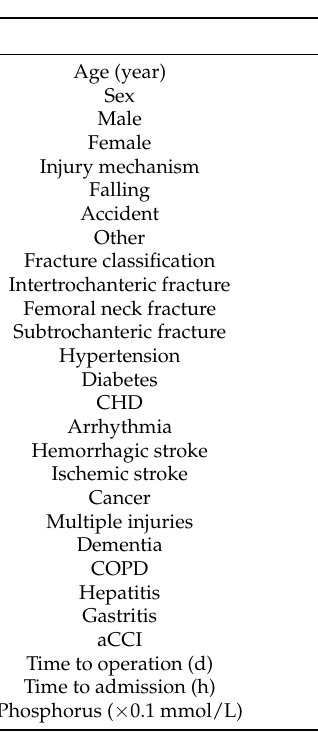
Table 2. Effects of factors on DVT measured by univariate